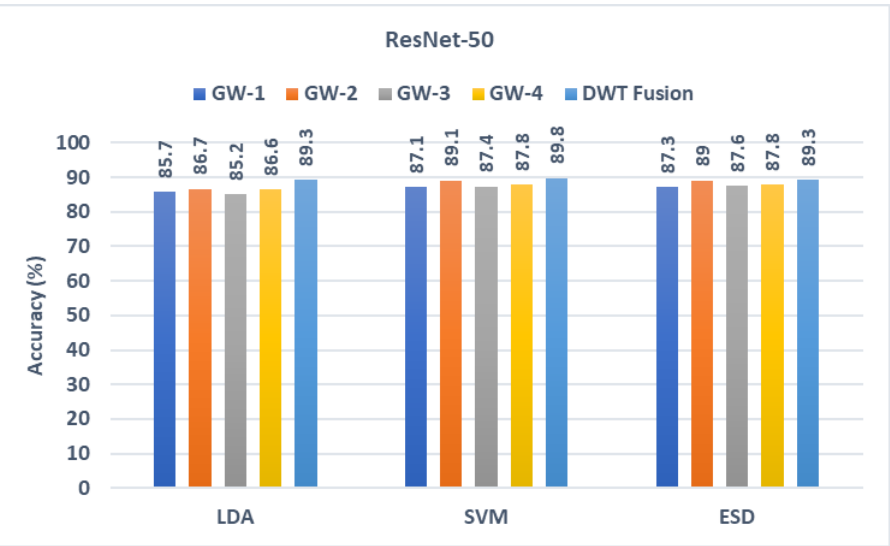
Figure 4. Diagnostic accuracy of the three classifiers trained with the features extracted from ResNet-50 learned using the individual GW images compared the fused DWT features.